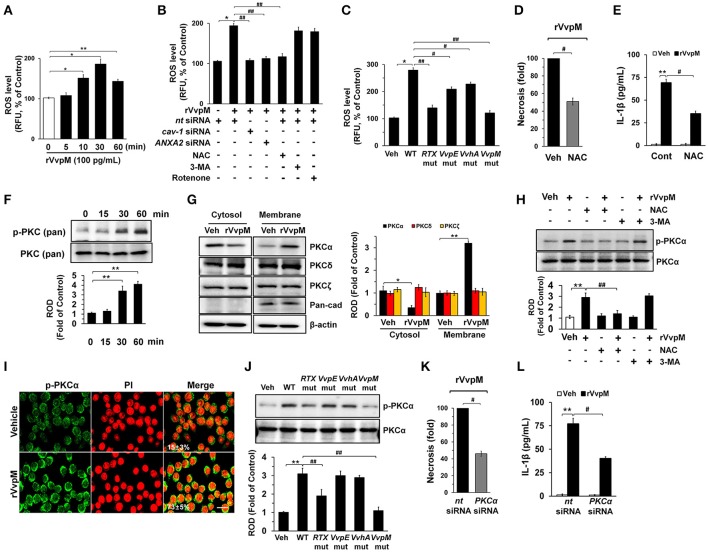
VvpM induces ROS production and PKCα phosphorylation. (A) Time responses of rVvpM in ROS production is shown. n = 4. (B) Cells were transfected with siRNAs for cav-1 and ANXA2 for 24 h or pre-treated with NAC (10 μM), 3-MA (10 mM), and rotenone (0.1 μM) for 30 min prior to rVvpM exposure for 30 min. n = 5. (C) Cells infected with WT or various mutant deficients for 30 min is shown. n = 4. (D) Cell were pre-treated with NAC (10 μM) for 30 min prior to rVvpM exposure for 24 h. FACS analysis and quantitative analysis of the percentage of necrotic (Q1) cells are shown. n = 4. (E) The level of IL-1β protein was quantified by ELISA. n = 5. (F) Phosphorylation of pan-PKC is shown. n = 3. (G) Membrane translocation of PKC isoforms in cells treated with rVvpM for 30 min is shown. Pan-cadherin was used as a membrane control. n = 3. (H) Phosphorylation of PKCα in cells pre-treated with NAC and 3-MA for 30 min prior to rVvpM exposure for 30 min is shown. n = 3. (I) Expression of PKCα (green) was determined by confocal microscopy. The cell numbers showing membrane translocalization of PKCα per microscopic filed were directly counted and converted to a percentage by multiplying by 100. Ten random fields per coverslip were counted. Data represent the mean ± S.E. n = 3. (J) Phosphorylation of PKCα in a cells infected with WT or various mutant deficients for 30 min is shown. n = 4. (K) Cells transfected with PKCα siRNA were incubated with rVvpM for 24 h. FACS analysis and quantitative analysis of the percentage of necrotic (Q1) cells are shown. n = 4. (G) The level of IL-1β protein was quantified by ELISA. n = 5. (A,F)
*P < 0.01 and **P < 0.001 vs. cells with no treatment, respectively. (B,K,L)
*P < 0.05 and **P < 0.01 vs. Veh (boiled WT), respectively. #P < 0.05 and ##P < 0.01 vs. nt siRNA + rVvpM, respectively. (C,J)
*P < 0.05 and **P < 0.01 vs. Veh (boiled WT), respectively. #P < 0.05 and ##P < 0.01 vs. WT, respectively. (D,E)
**P < 0.01 vs. Veh (boiled rVvpM). #P < 0.05 and ##P < 0.01 vs. Veh + rVvpM, respectively. (G,H)
*P < 0.01 and **P < 0.001 vs. Veh (boiled rVvpM), respectively. ##P < 0.05 vs. rVvpM alone. ROD, relative optical density; RFU, relative fluorescence units.